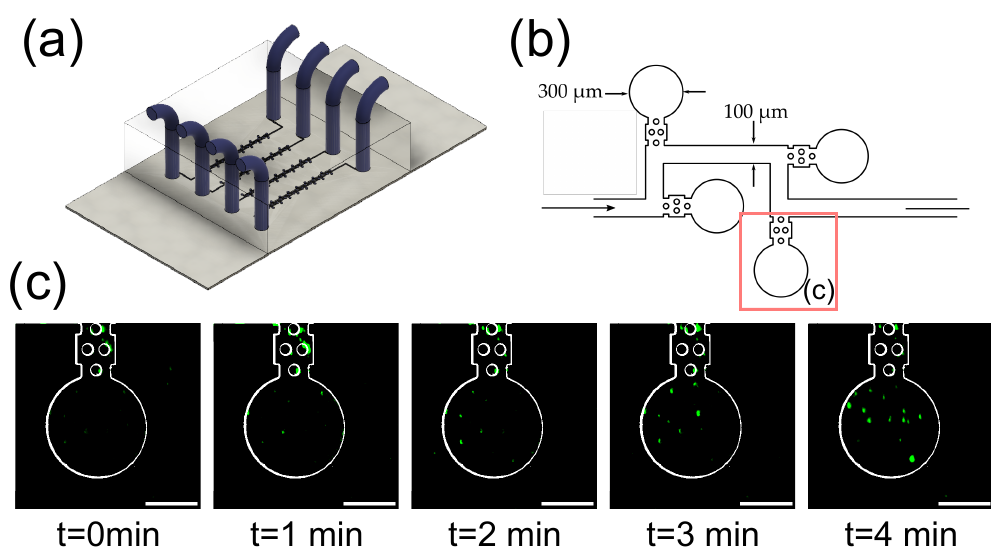
Figure 5. Microbeads being entrapped in microfluidic chambers. ( a ) Scheme of the microfluidic device used for zero-flow bacterial entrapping; ( b ) Detail of the microfluidic channel showing the zero-flow chambers where bacteria are loaded (left side), and subsequently, media can be passed from the feeding direction (right side) and reached the entrapped bacteria by diffusion; ( c ) 1 µ m fluorescent bead being trapped inside the microfluidic chamber. The microfluidic device outlines have been obtained from the brightfield image. Scale bar: 100 µ